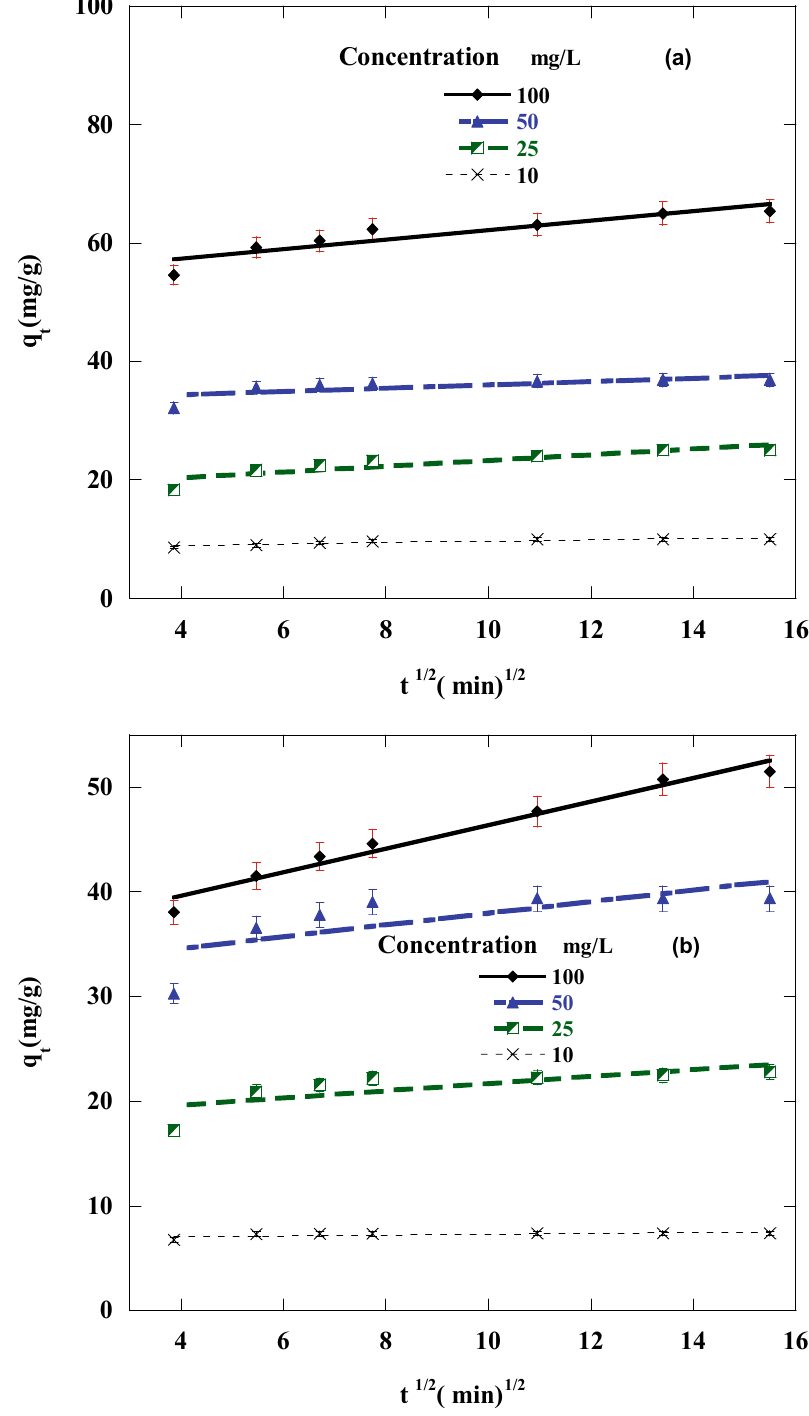
Figure 12. Plots for evaluating intraparticle diffusion rate constant for sorption of Disperse red 60 dye at 20 °C and pH 6 by 50 mg of : ( a ) CF, ( b )